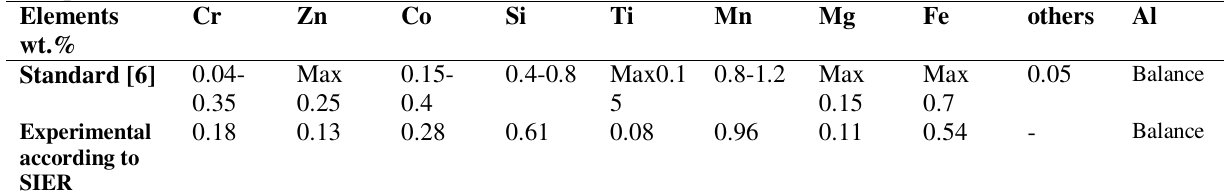
Chemical analysis of 6061 Al. alloy examined at state company for inspection and engineering (SIER) wt. % in comparison with Ref [6].